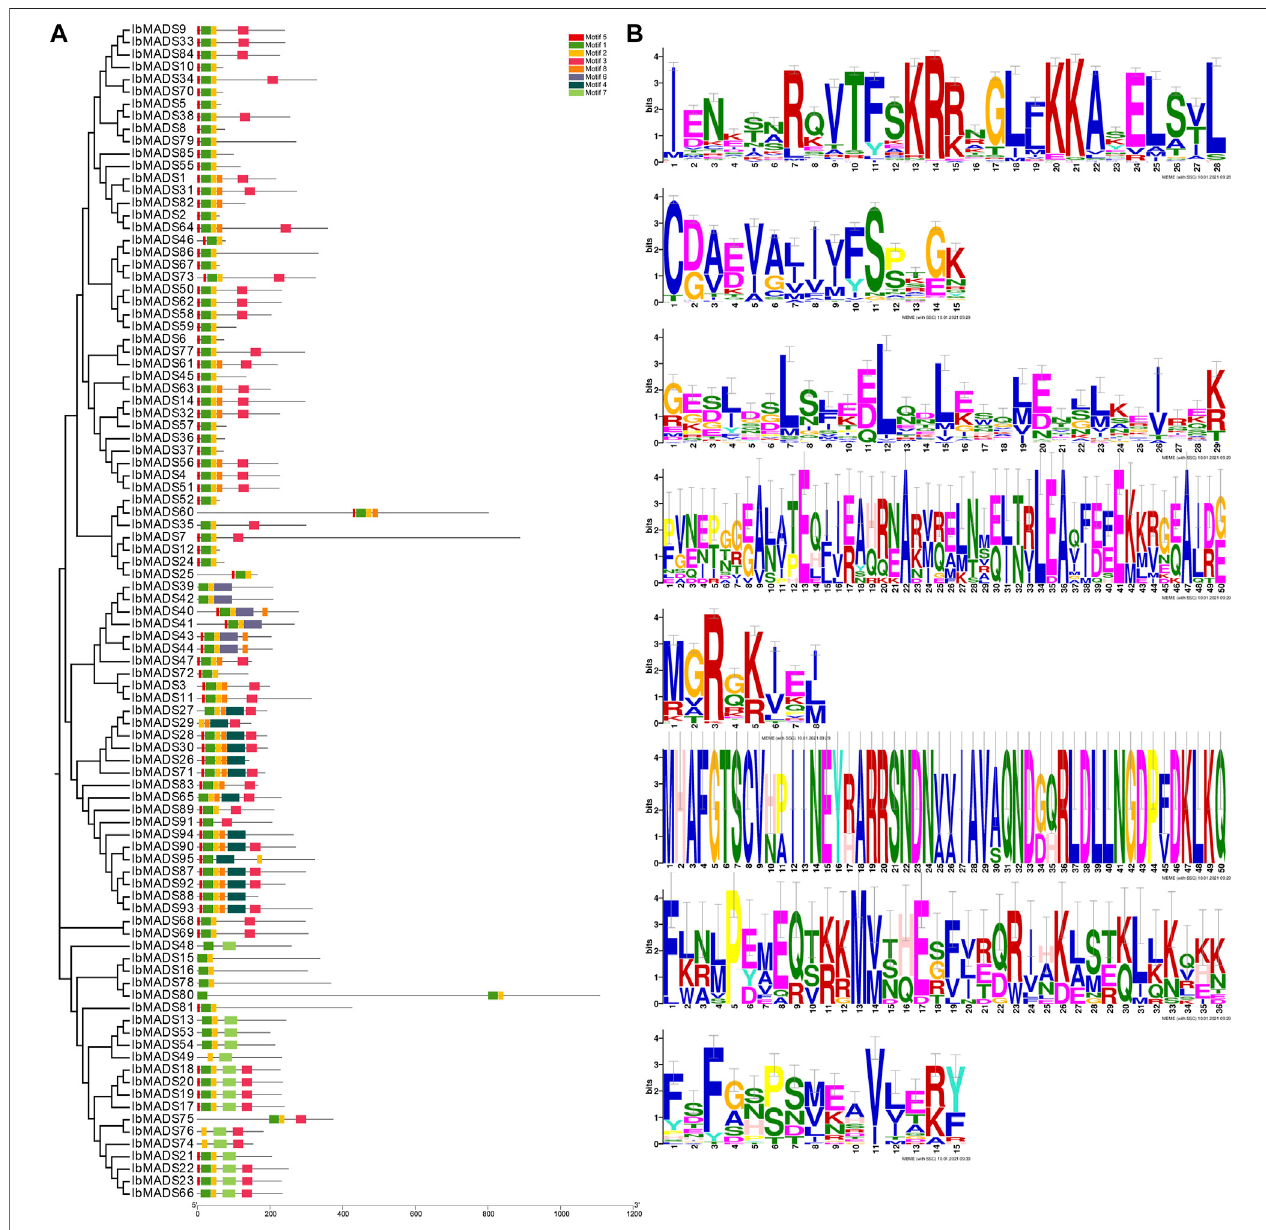
FIGURE 4 | Analysis of MADS-protein motif domain in sweet potato (A) and motifs (B) .